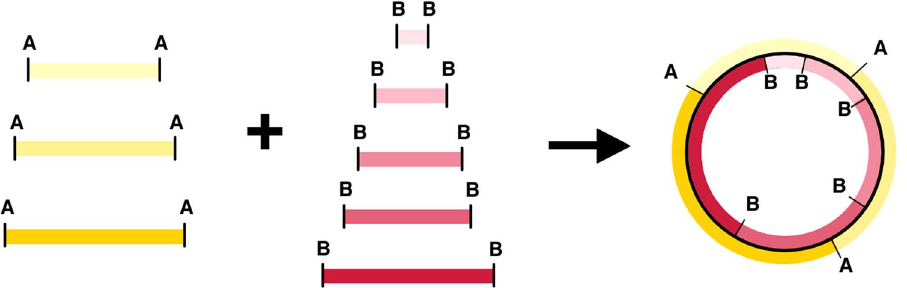
Figure 1. Nesting approach to designing molecular weight marker plasmids. Two distinct sets of ladder fragments delineated by restriction sites A and B can be nested together to form a single, compact plasmid. We implemented this approach using PCR primers to integrate restriction sites into amplified fragments from the source DNA.